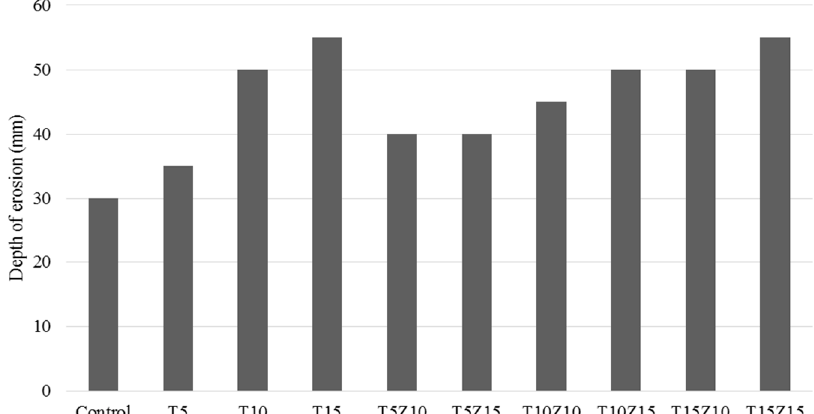
Figure 8. Depth of Figure 8. Depth of erosion. Figure 8. Depth of erosion. Figure 8. Depth of erosion.